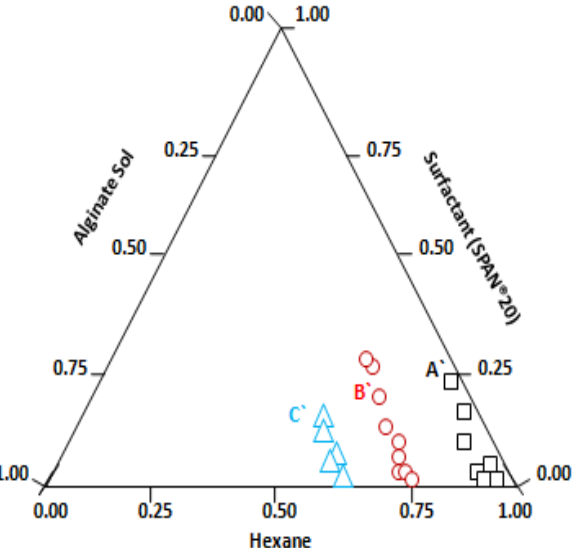
Figure 2. Phase diagram for alginate sol/hexane/Span 20 microemulsions. Squares ( ), circles ( ) and triangles ( ) correspond to the microemulsion regions where the micelle size varies from 110 nm to 231 nm, 431 nm to 586 nm, and 886 nm to 1163 nm, respectively.